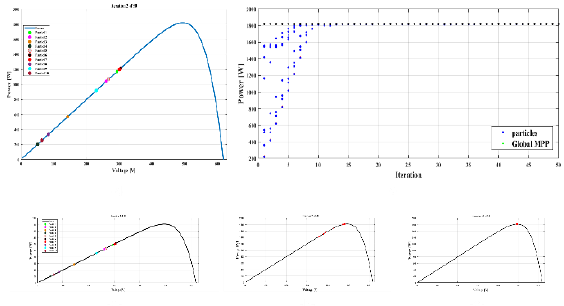
Fig. 9. Instant change of irradiation (scenario 1).